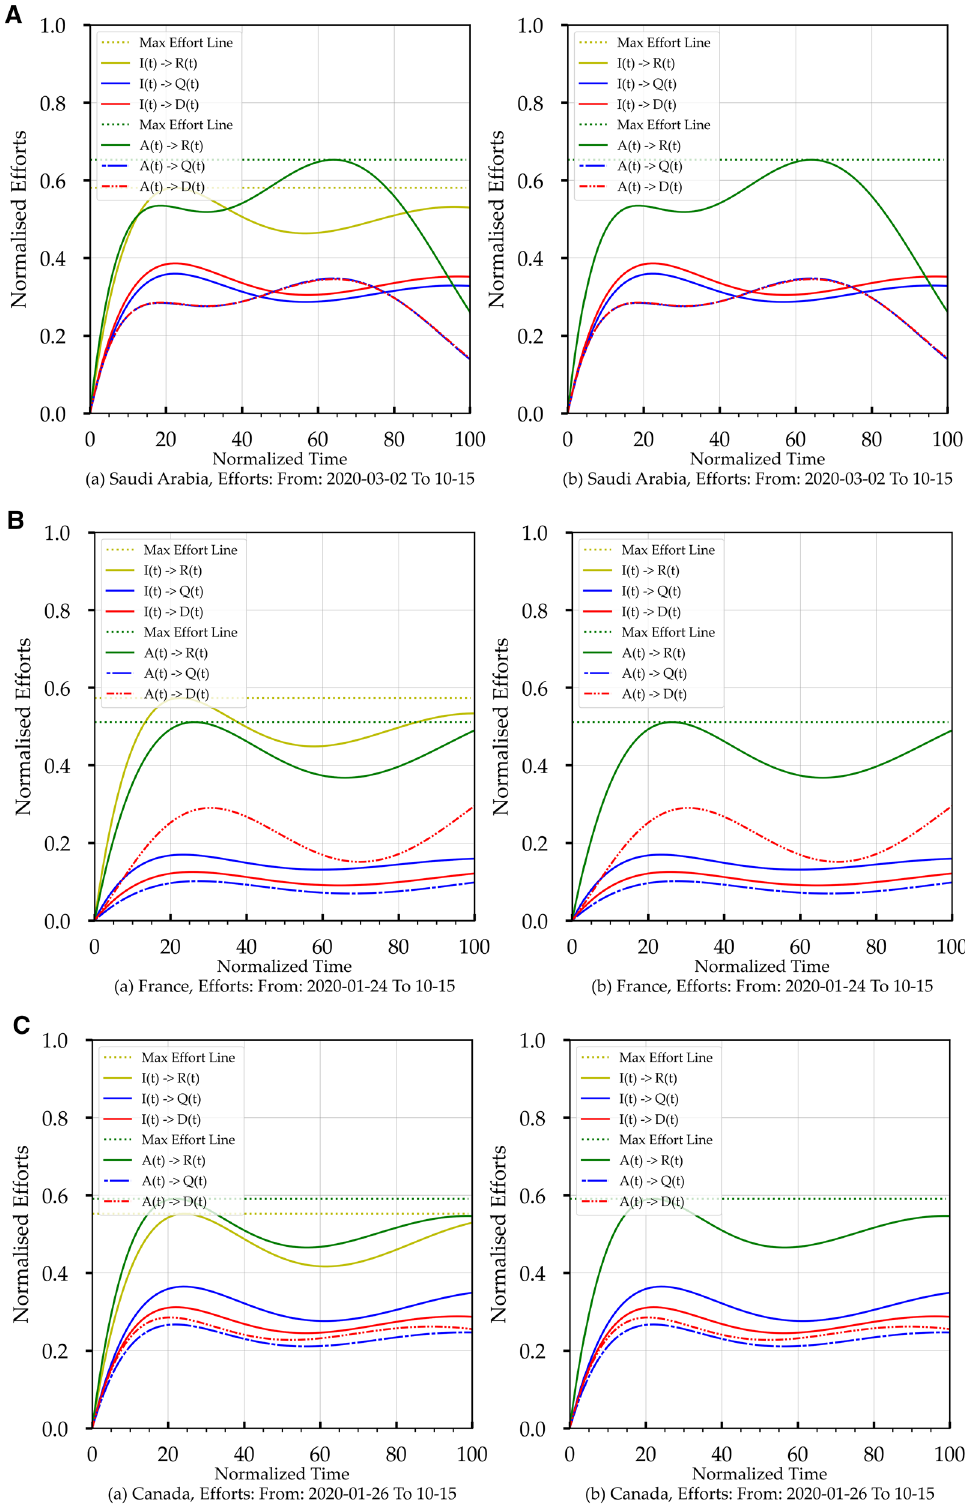
Figure 8. ( A ) The Increasing Version of the Health Efforts Function (CETR) for Saudi Arabia, Source Stages: Infected and Active. (a) covers the period from March 2nd, 2020, to October 15th, 2020. (b) covers the